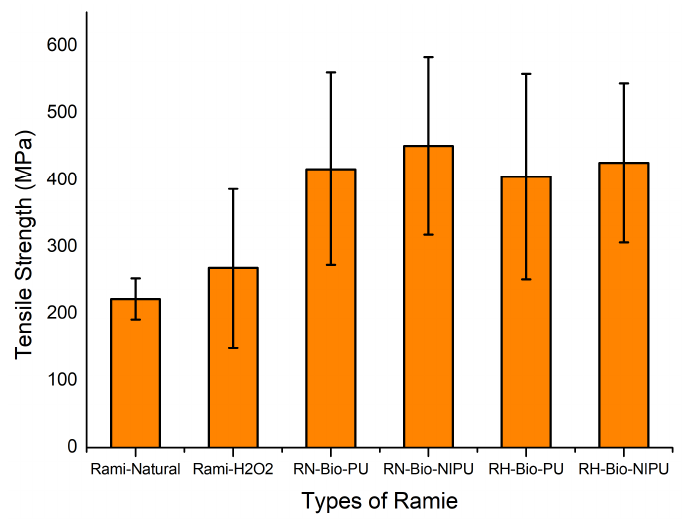
Figure 14. Tensile strength of different types of impregnated ramie with different resins. Table 3. Summarized results of tensile strength and MOE of ramie fibers. Ramie Type Resin